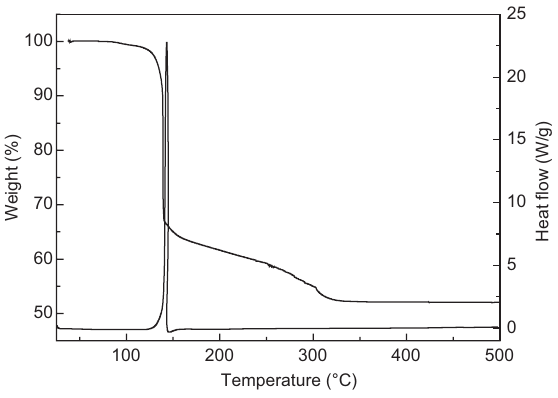
Figure 1 DSC and TGA thermograms of a pure Ag(acac) sample.